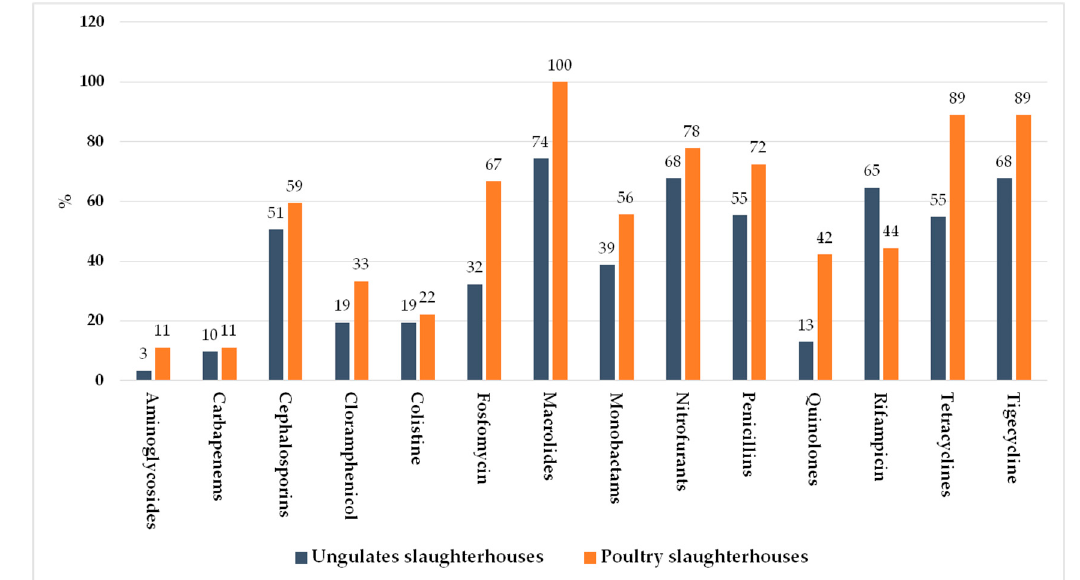
Figure 5. Antibiotic resistance of the strains detected in wastewater from the two different types of studied slaughterhouses (ungulates and poultry).